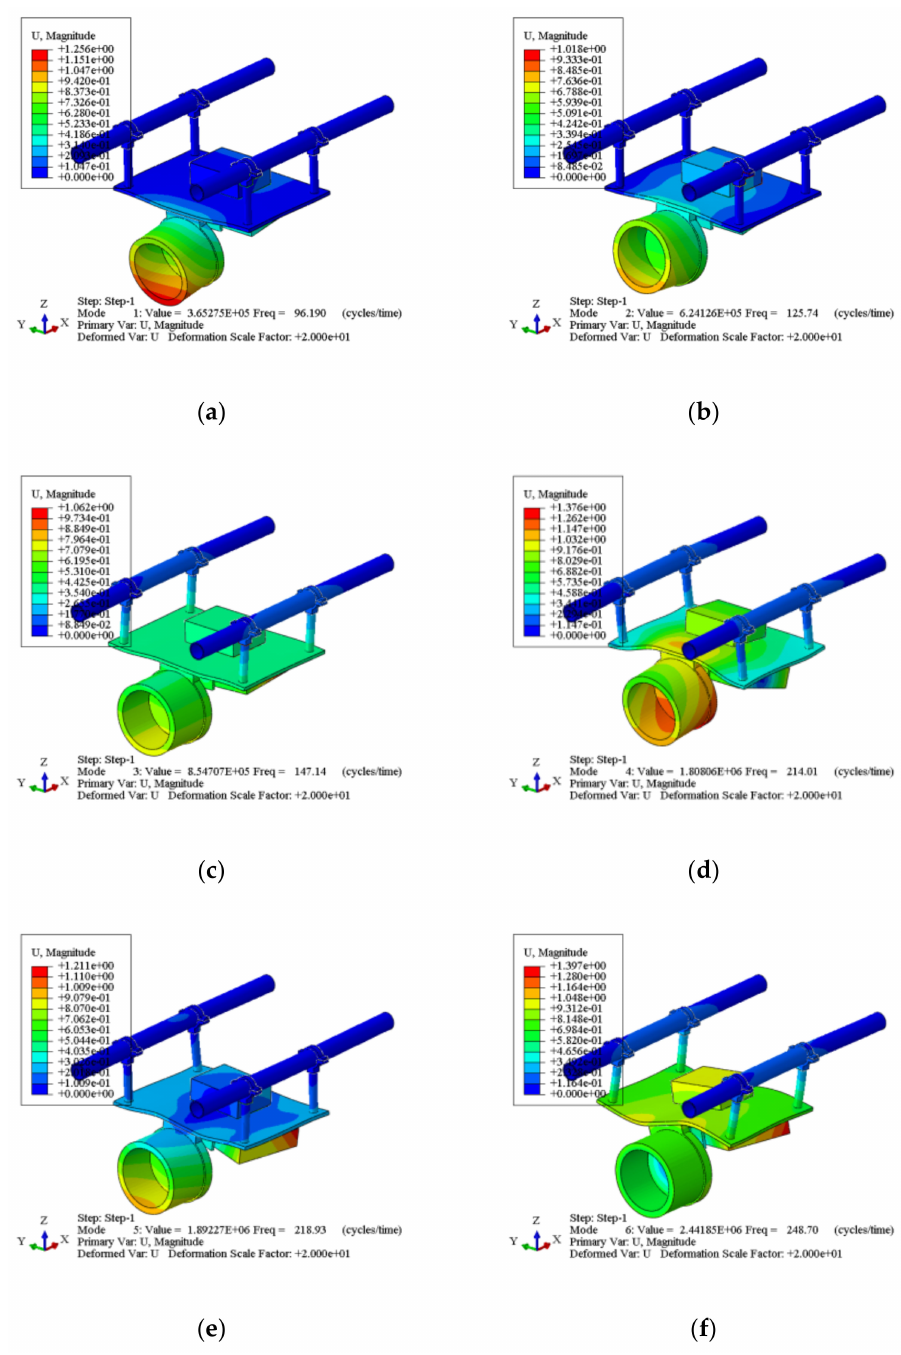
Figure 15. The first six modes of the UAV LiDAR: ( a ) First-order mode; ( b ) Second-order mode; ( c ) Third-order mode; ( d ) Fourth-order mode; ( e ) Fifth-order mode; ( f ) Sixth-order